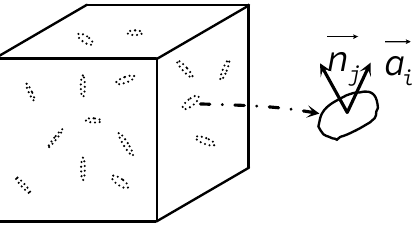
Figure 1. Representative volume element with internal damage variables for piezoelectric